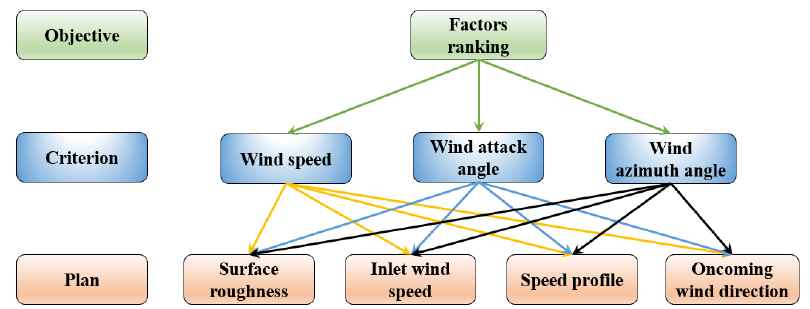
Figure 11. Hierarchical structure diagram.